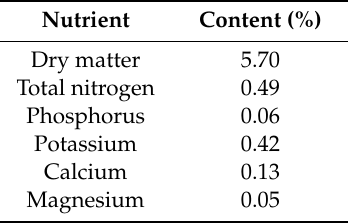
Table 1. Chemical composition of digestate (measured in 100 g of